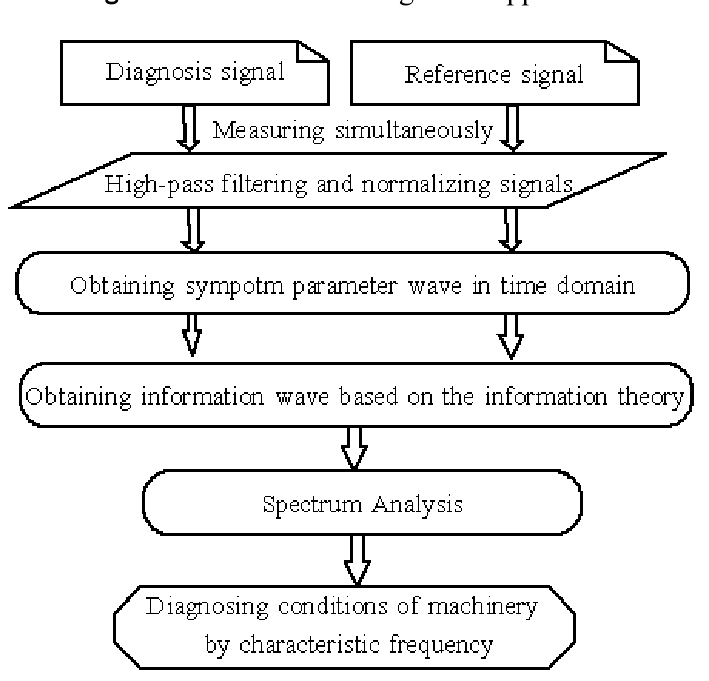
Figure 2. Flowchart of diagnostic